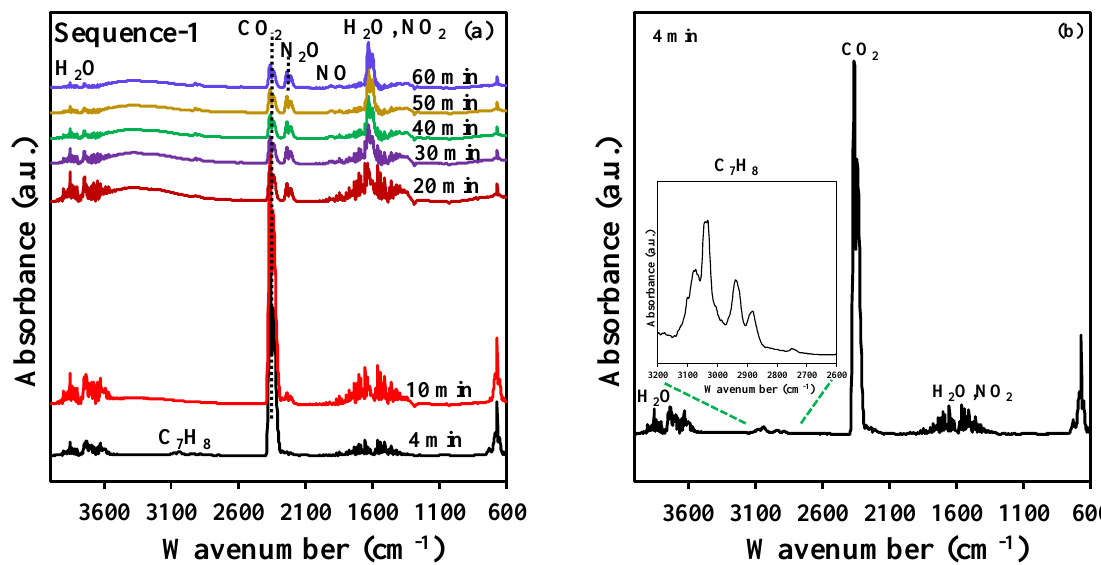
Figure 2. ( a ) Example of FT-IR spectra of the outlet gas at various times during plasma treatment (data collected for experiment using t 1 = 20 min), ( b ) FT-IR spectrum at 4 min (inset: zoom within the 2600–3200 cm − 1 range).